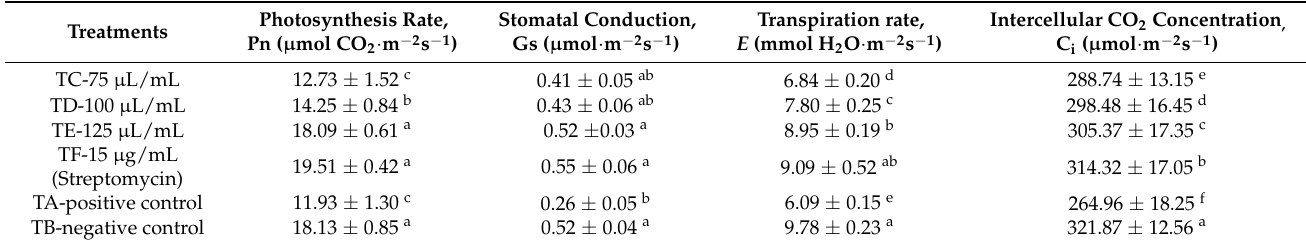
Table 4. Effect of developed nanobactericides application on photosynthesis rate (Pn), transpiration rate ( E ), stomatal conductance (Gs), and intercellular CO 2 concentration (C i ) of rice plant after being challenged with bacterial leaf bight disease in a glasshouse